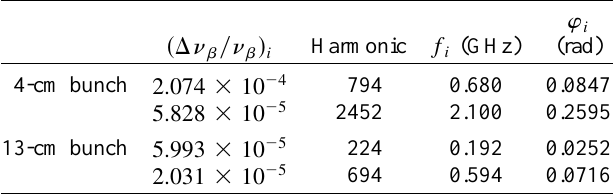
TABLE III. Two sinusoidal fits for tune-shift compensation.